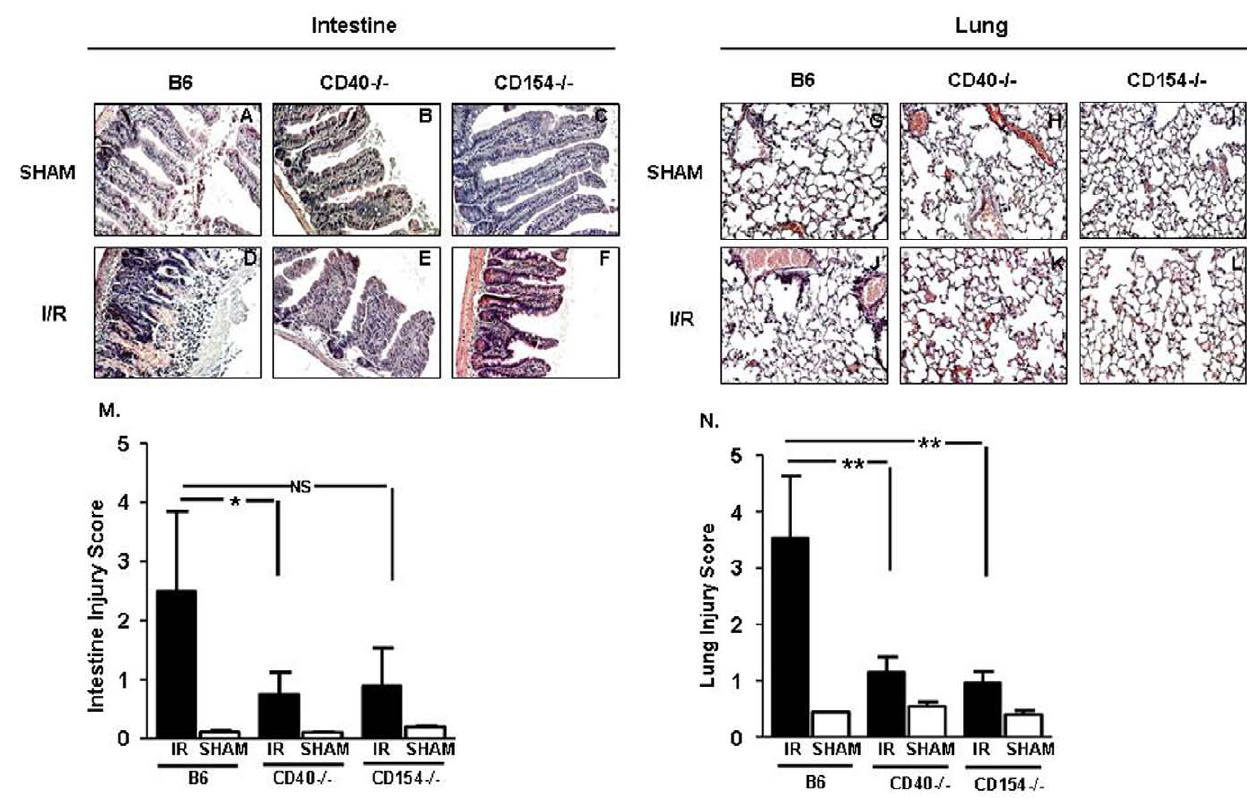
Figure 1. Intestinal and lung injury is reduced after mesenteric ischemia/reperfusion in CD40 2 / 2 and CD154 2 / 2 mice. Hematoxylin and eosin stained sections of mouse small intestine after 30 minutes of ischemia and 3 hours reperfusion. Images are representative of 3–4 mice per group in two experiments. (A–F) Images of intestinal villi from sham and I/R. (G–L) Images of lung from sham and I/R, platelet-deficient sham and I/R. All images shown are 200 6 magnification. (M, N) Injury score (mean 6 SD) in intestine and lung. *p # 0.05, **p # 0.01, and ***p # 0.001 for I/R compared to sham controls.